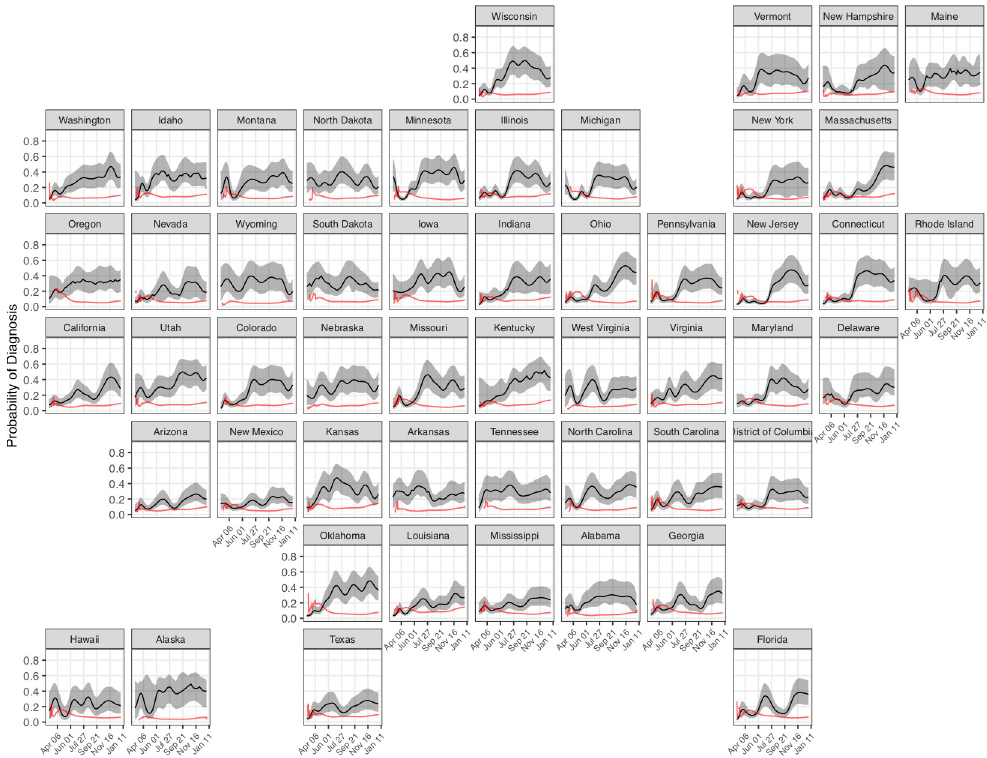
Fig 6. The probability that a person infected with SARS-CoV-2 on a given day will be diagnosed for each US state from March 1, 2020 to January 1, 2021. Shaded areas represent 95% credible intervals. The red line represents a seven-day moving average of the fraction of positive